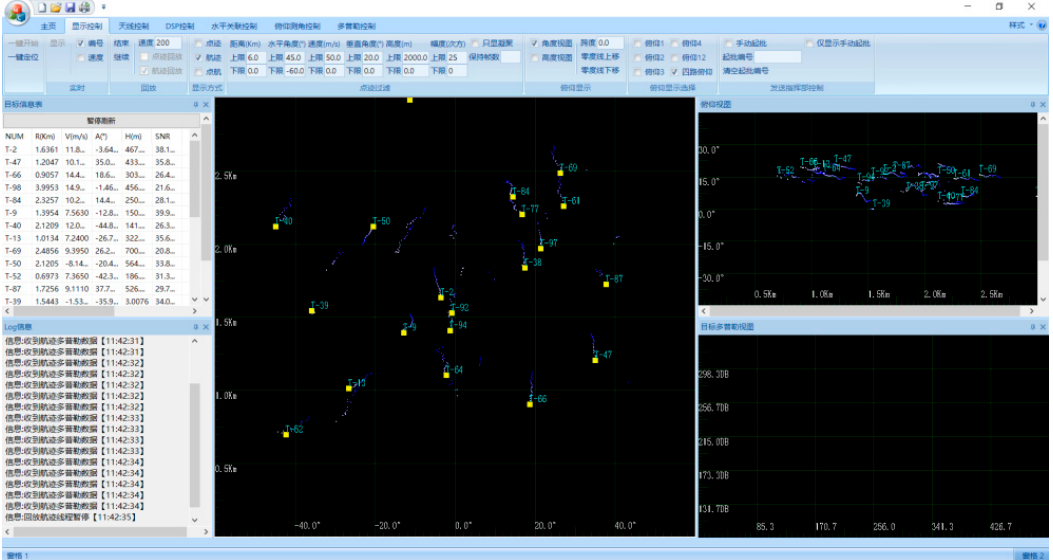
Figure 11. Interface of the software operation platform.